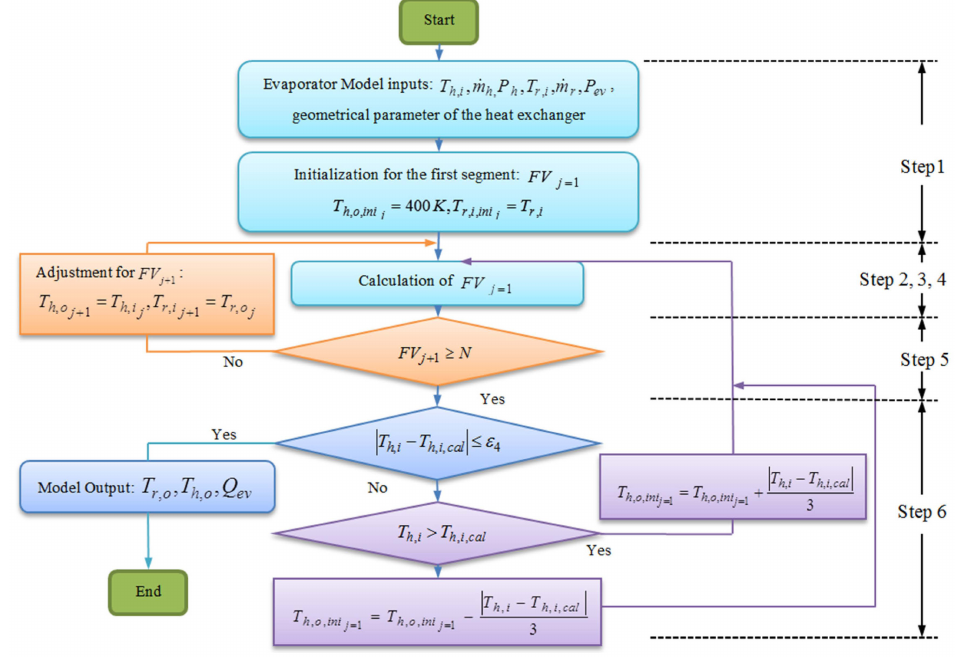
Figure 6. Finite volume calculations for all segments of the evaporator.